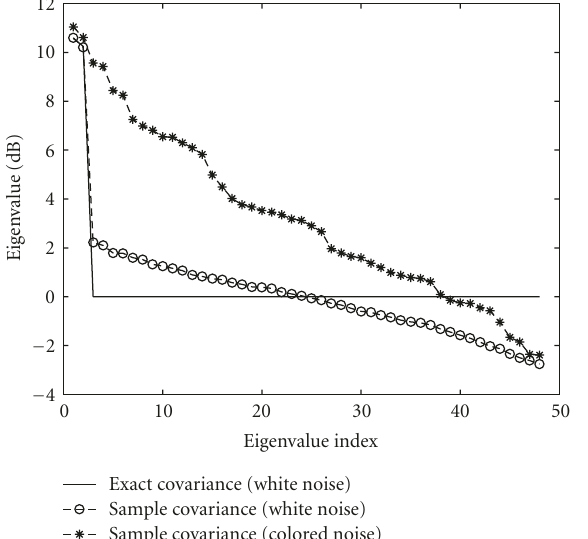
Figure 10: Eigenvalue spectrum of the sample covariance matrix with M = 12, K = 4, N = 100, and SNRs = 10dB.